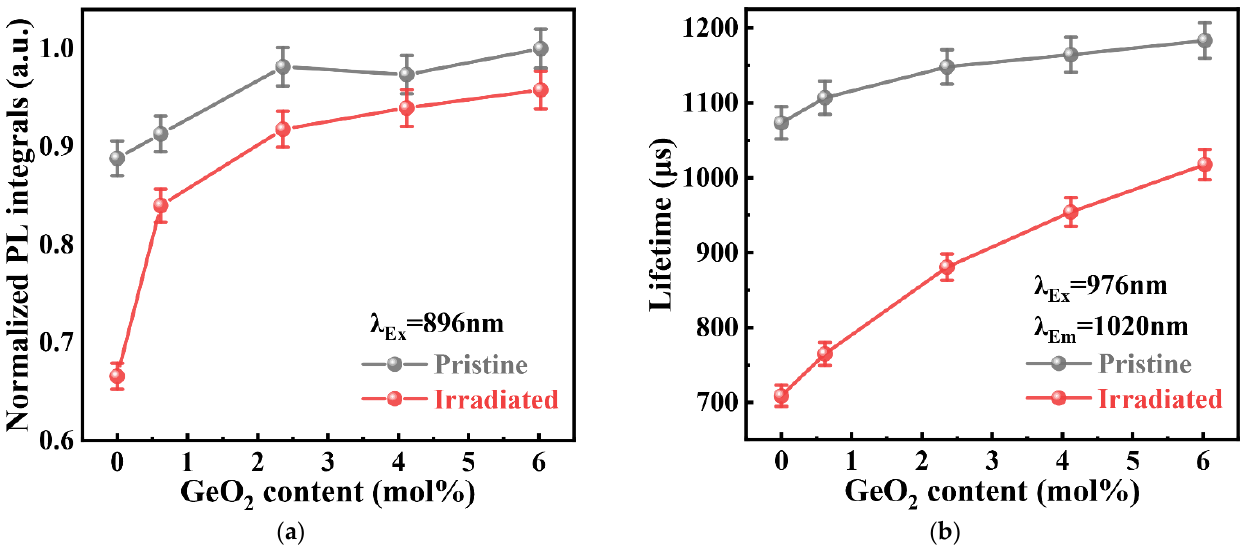
Figure 6. ( a ) Fluorescence integral intensity and ( b ) fluorescence lifetime of GAY samples before and after irradiation.